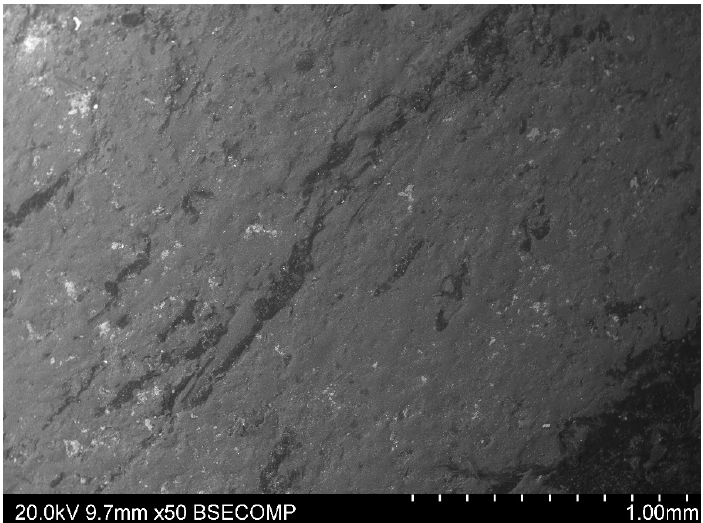
Figure 5 . Scanning electron microscope (SEM) micrograph of the plate obtained in the press moulding process .